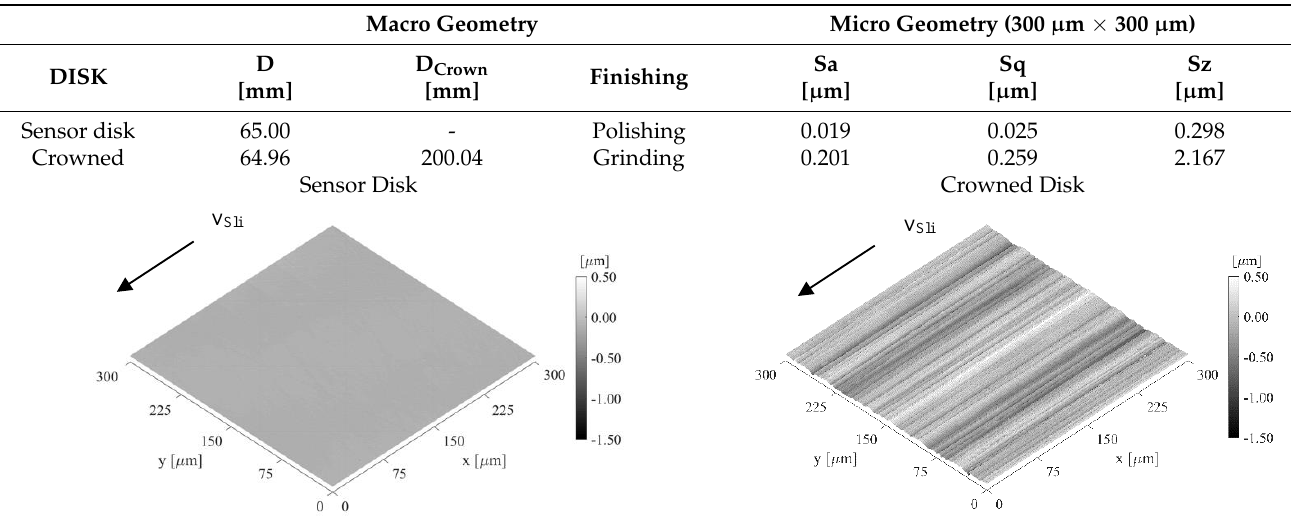
Table 1. Macro and micro geometry.